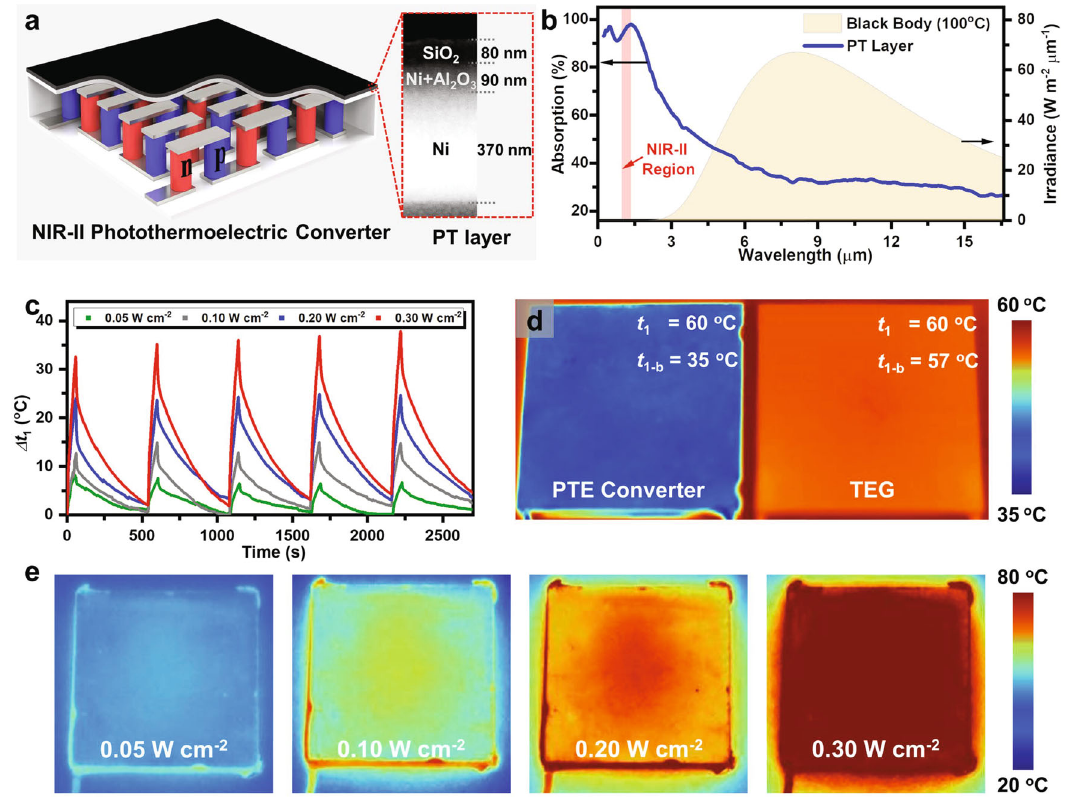
Fig. 2 | The design and characterization of PT layer. a Schematic of the com- positionofthe PT layer.Inset:corresponding scanningelectron microscope image of the PT layer, which consists of three layers, from top to bottom including an 80nm of SiO 2 , a 90-nm-thick Ni/Al 2 O 3 complex layer, and a 370-mm-thick Ni sub- strate. b The absorption spectrum of PT layer, and its comparison with the irra- diance from a blackbody at 100°C. c The temperature changes of the PT layer coating on a TE generator under cycles of on – off NIR-II light irradiation with